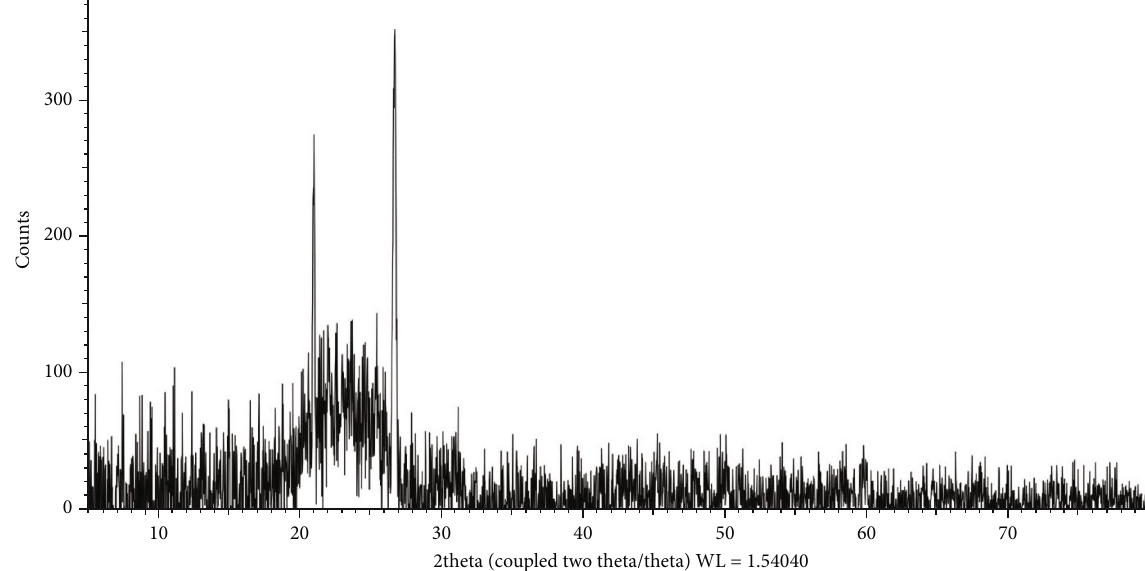
Figure 3: XRD spectra of the synthesized